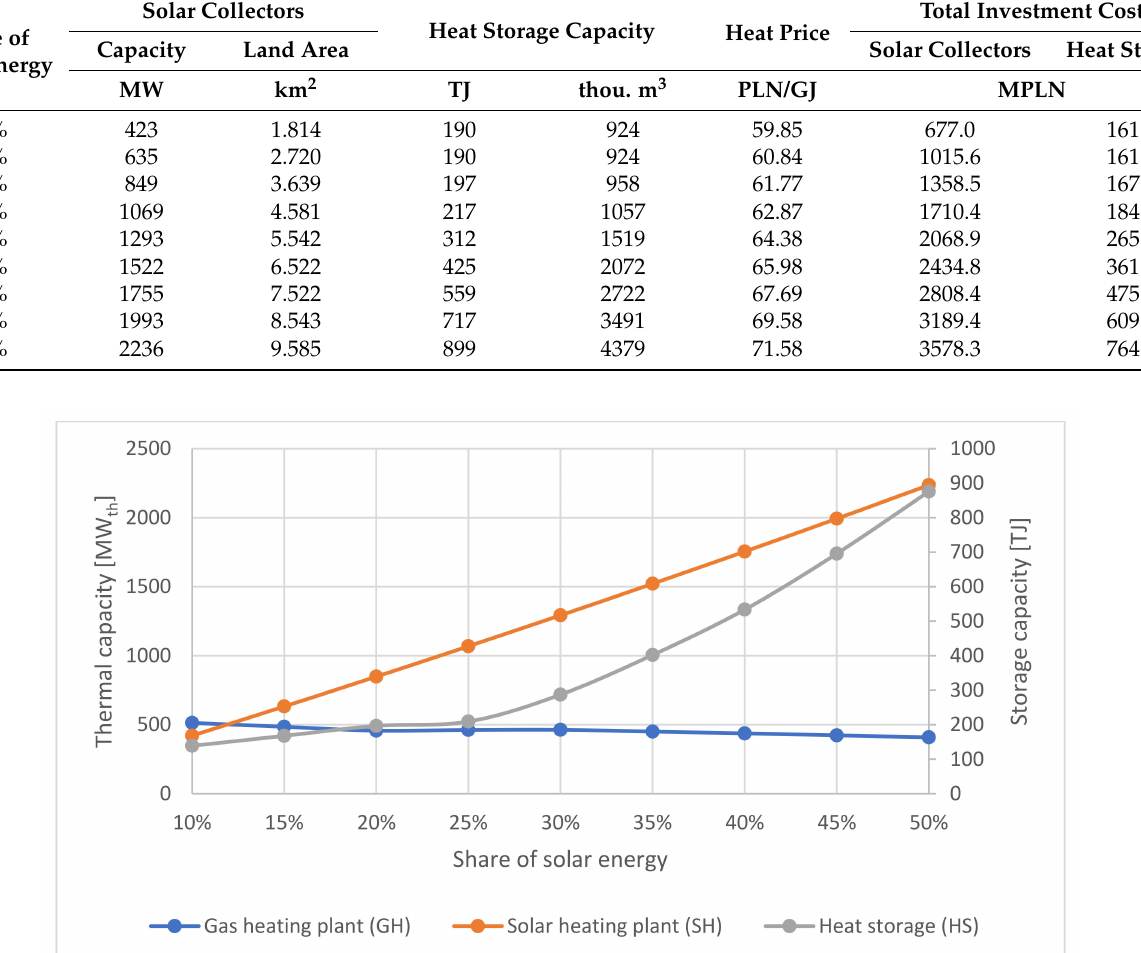
Figure 6. Sensitivity analysis—thermal power of the technology and storage capacity as a function of the share of solar